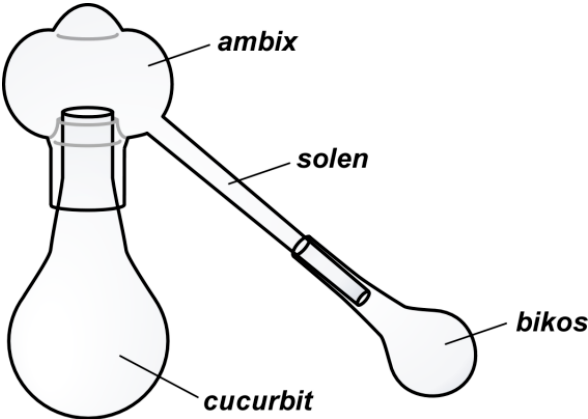
Figure 1. Basic components of the early still [ reprinted from refer- ence 22 with permission from Springer Nature